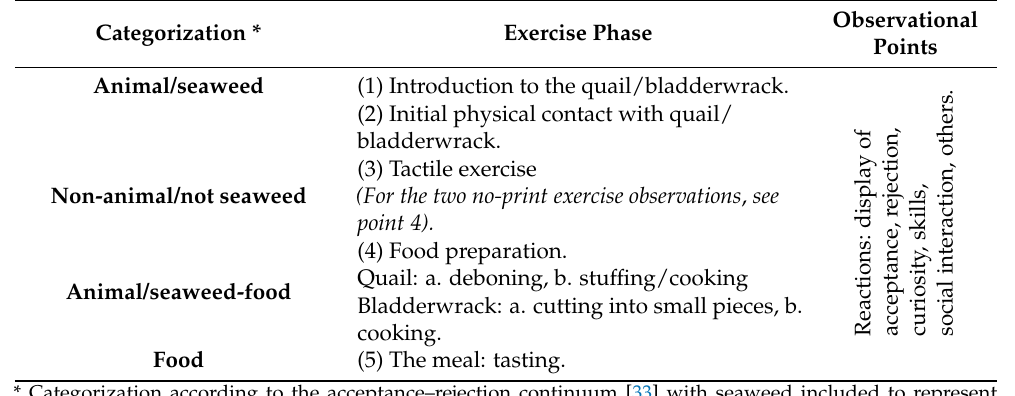
Table 1. Observation